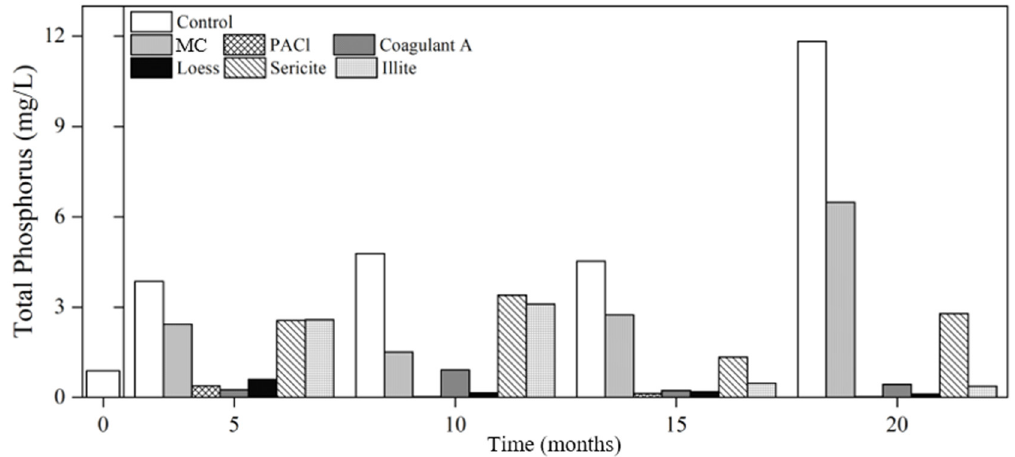
Figure 3. Changes in total phosphorus concentrations in the control and treatments with coagulants and minerals. MC: mineralized coagulant; PACl: polyaluminum chloride; A: commercial coagulant.